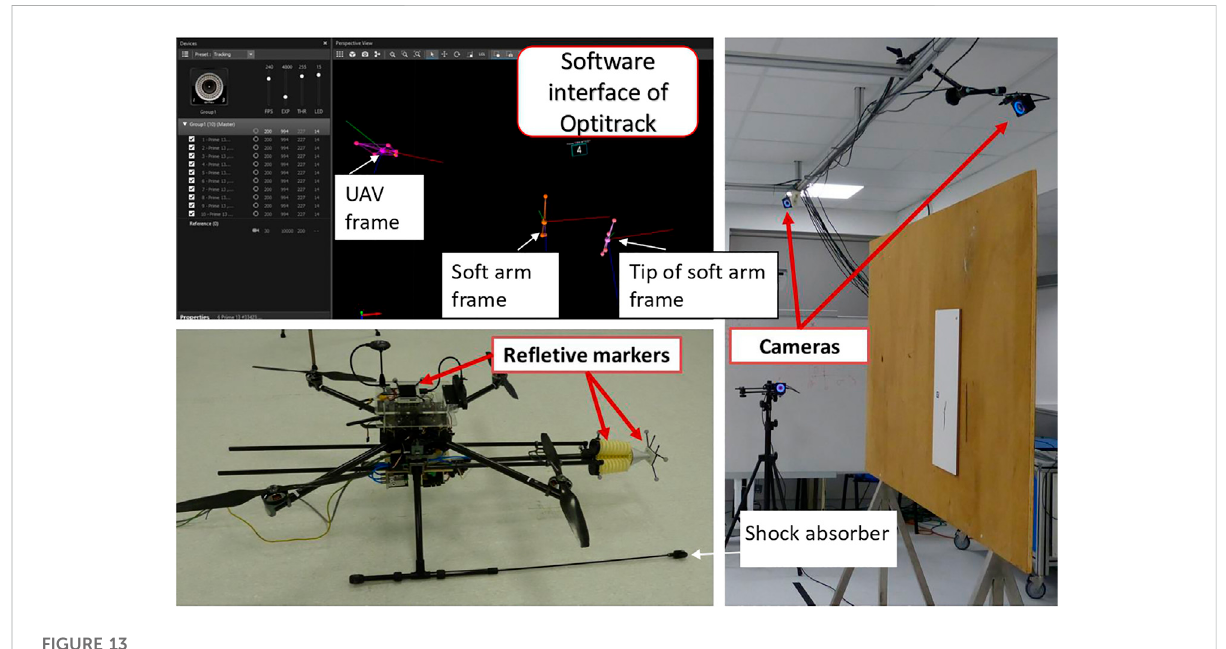
FIGURE 13 Stereo-vision system for trajectory